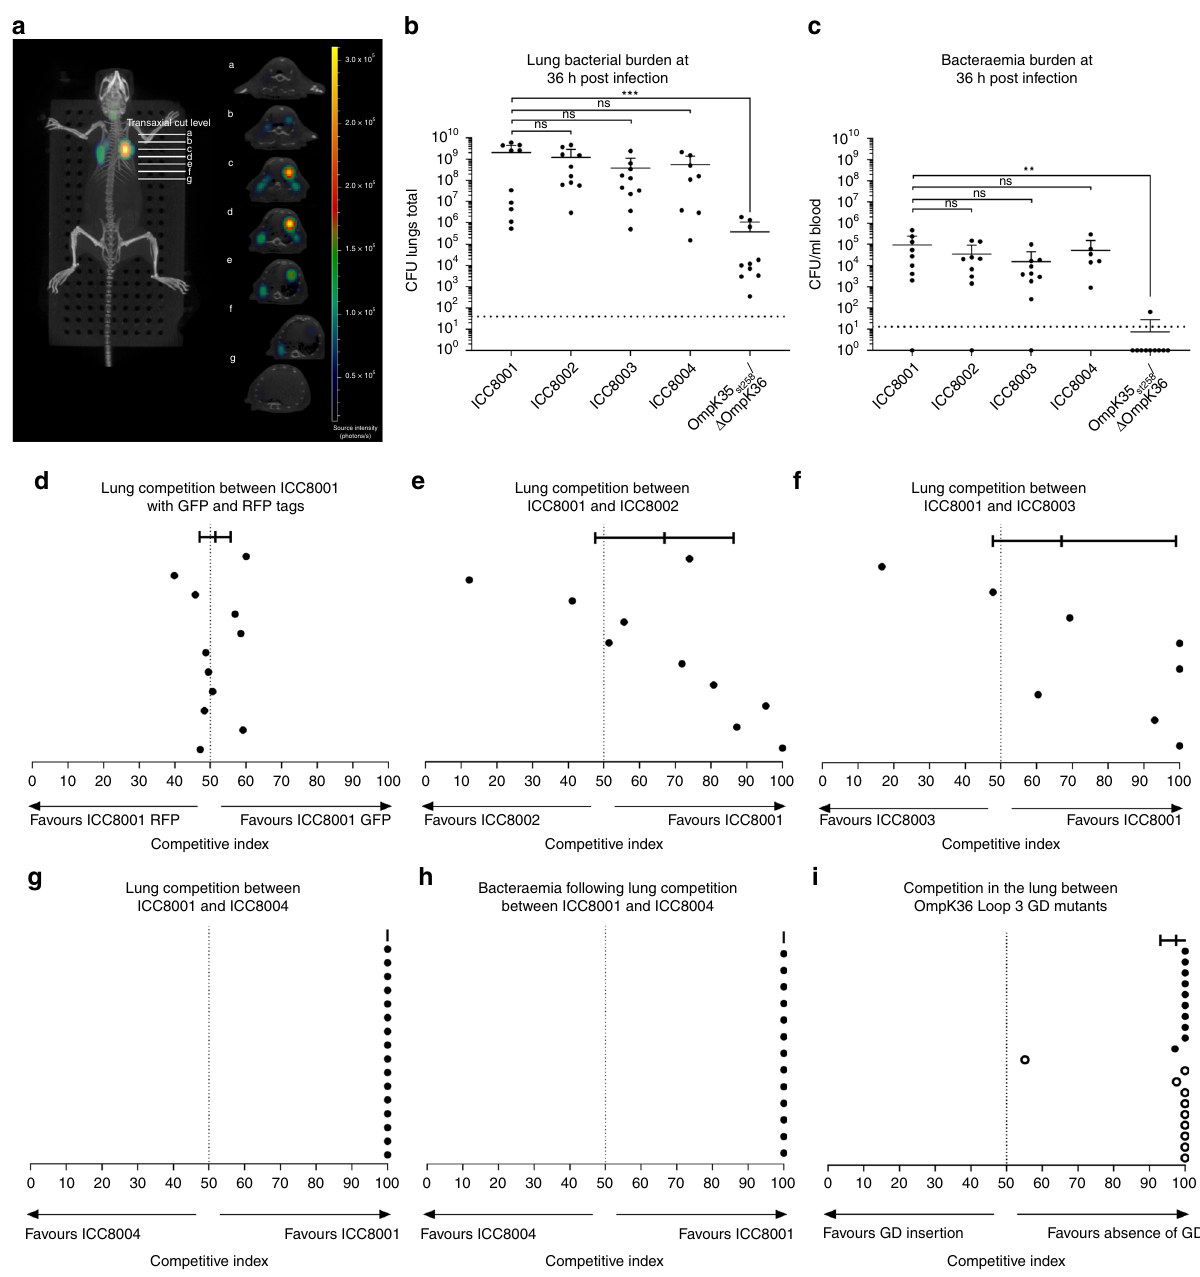
Fig. 4 The Gly-Asp insertion in Asp L3 causes a fi tness disadvantage in an in vivo model of Ventilator-associated pneumonia. a Delivery of bioluminescent KP to the lung parenchyma by intubation recorded by 3D-diffuse light imaging immediately post inoculation. Images were reconstructed into 3D using 3D living image. b , c Mice were intubated with 500 CFU of ICC8001-ICC8004 or OmpK35 ST258 / Δ OmpK36 ( n = 10/strain, error bars ± s.d.). Enumeration of CFU in lungs and blood, collected at 36 h post infection, revealed no signi fi cant difference between ICC8001 and all strains tested except OmpK35 ST258 / Δ OmpK36. ** p < 0.001, *** p < 0.0002. d Competition between ICC8001-GFP and ICC8001-RFP was tested by intubating 250 CFU or each competing strain. Enumeration of CFU of each strain in lungs and blood, identi fi ed by their colony fl uorescence, was performed at 36 h post infection. Top bar represents mean value, points below represent individual mice ( n = 10 per competition, error bars ± 95% con fi dence interval). No signi fi cant difference between ICC8001-GFP and ICC8001-RFP was detected in either the lungs or blood (Fig. S9d). e Competition between ICC8001 and ICC8002 (OmpK35 ST258 ) and f ICC8001 and ICC8003 (OmpK36 ST258 ) result in non-signi fi cant fi tness disadvantage in the lung, but signi fi cant attenuation in dissemination to the blood (Fig S9e, f) ( n = 10 per competition, error bars ± 95% con fi dence interval). g , h ST258 con fi guration at both OmpK35 and OmpK36 loci (ICC8004) results in complete out-competition by WT con fi guration (ICC8001) at 36 h post inoculation in the lung and dissemination to the blood, with no recoverable ICC8004 at either site ( n = 16, error bars ± 95% con fi dence interval). i Competition between OmpK36 isogenic pairs with or without Gly-Asp Loop 3 insertion demonstrates that in vivo disadvantage results from pore constriction. Top bar represents mean value ( n = 20 mice, error bars ± 95% con fi dence interval), OmpK36 WT in competition with OmpK36 WT + GD (open circles, each point represents 1 mouse ( n = 10)) or OmpK36 ST258 in competition with OmpK36 ST258 Δ GD (closed circles, each point represents 1 mouse ( n =